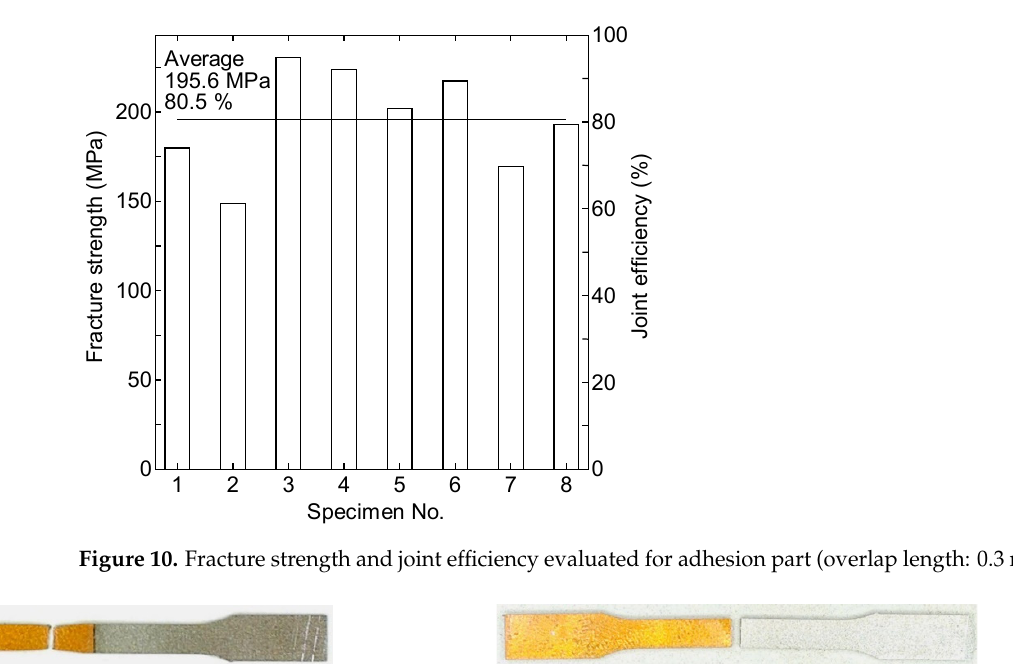
8 of 14 Figure 9. Schematic of tensile test specimen joined using sheared surface. The joint efficiency is shown in Figure 10. The average is as high as about 80%. The fractured specimens are shown in Figure 11. It should be noted that the No. 3 specimen fractured at the material of C1100 exhibit a diffuse necking. However, the joint efficiency is 95%. This is because the ultimate tensile strength of the material was evaluated for the